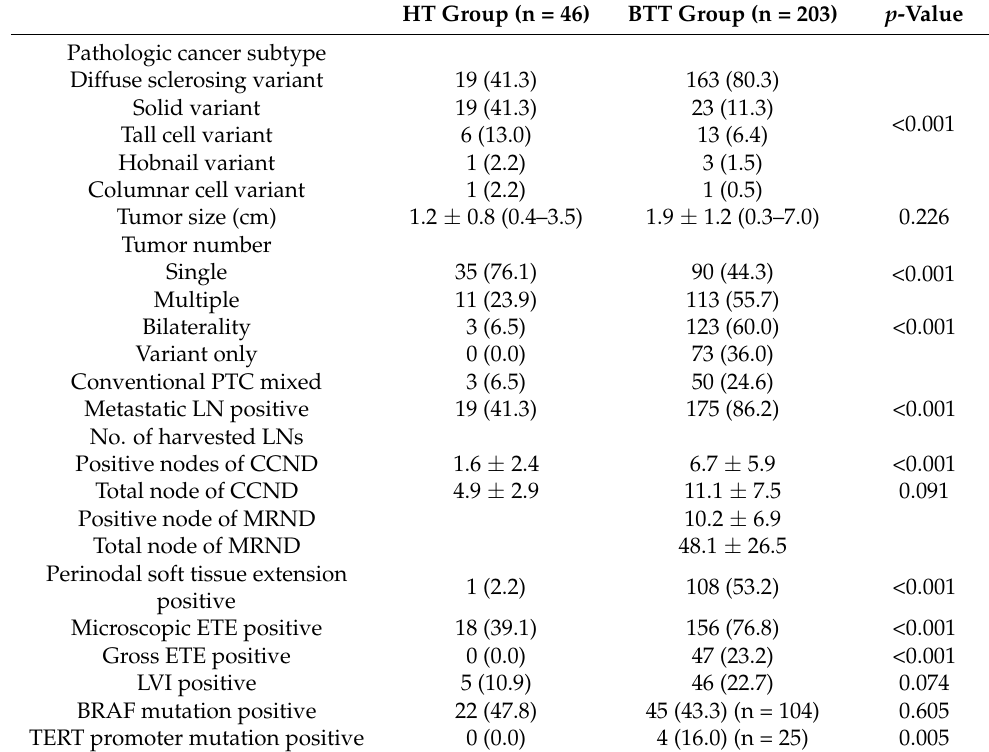
Table 3. Comparison of pathological findings and gene mutation between patients treated with HT and BTT. HT Group (n = 46) BTT Group (n = 203) p -Value Pathologic cancer